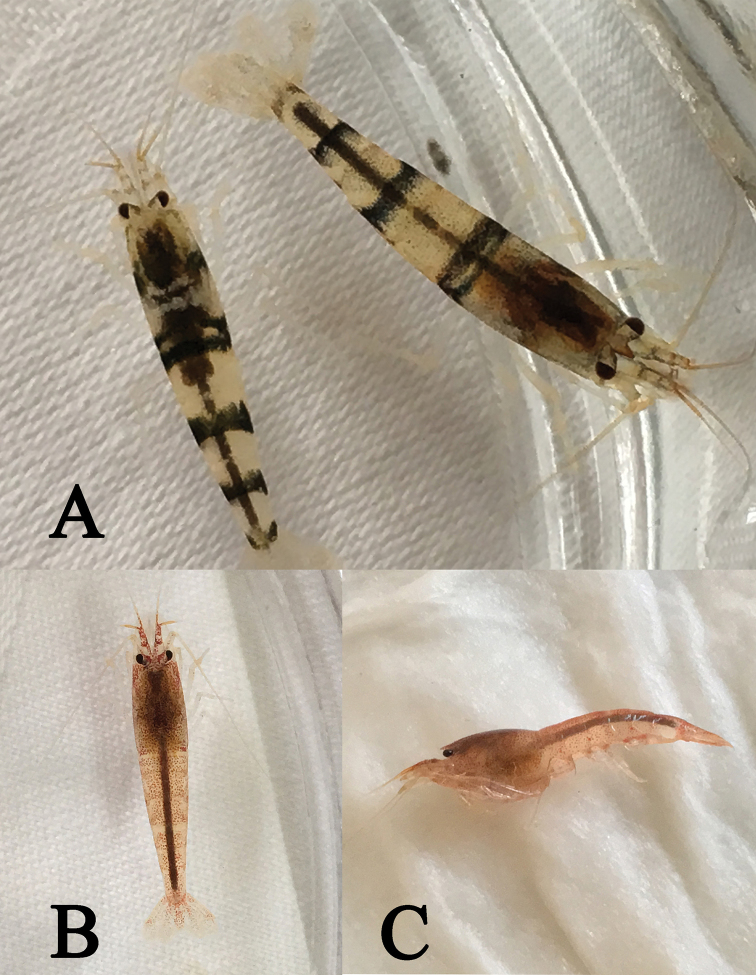
Photos of live specimens of the two species of Caridina from Dawanshan Island. ACaridina
tetrazona sp. nov. B dorsal view of C.
serrataC lateral view of C.
serrata.